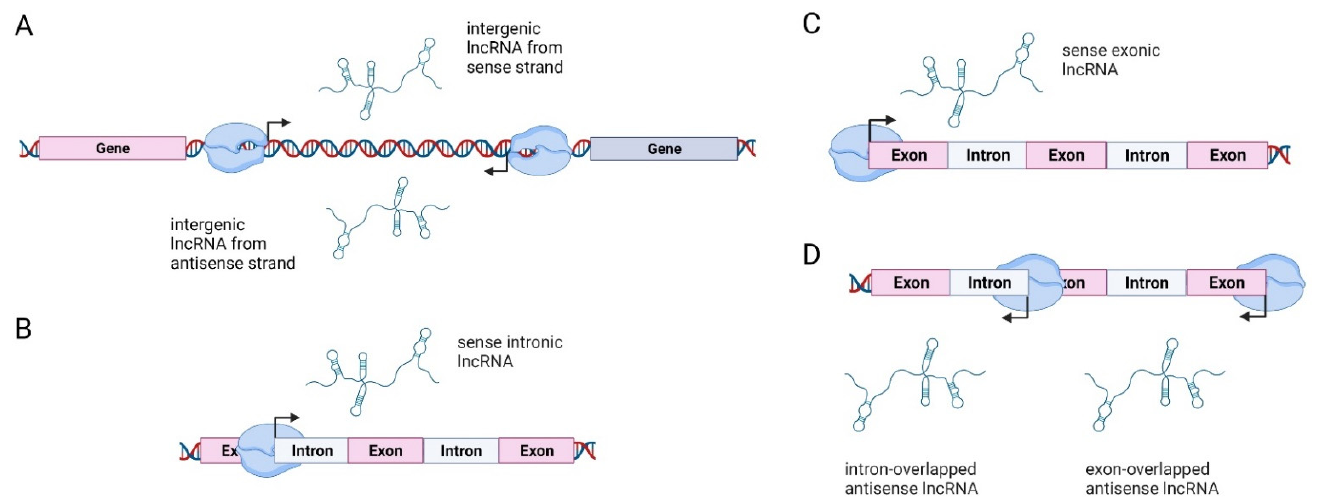
Figure 1. Categories of lncRNAs based on their location in respect to protein-coding genes. ( A ) Long intergenic non-coding RNAs (lincRNA) are transcribed intergenically from both strands. ( B ) Sense intronic transcripts are located within introns of coding genes without intersecting with exons. ( C ) Sense overlapping transcripts overlap with the exons of coding genes on the same strand. ( D ) Antisense RNAs are located within the exons and introns of protein-coding genes but on the opposite strand. Created with BioRender.com .